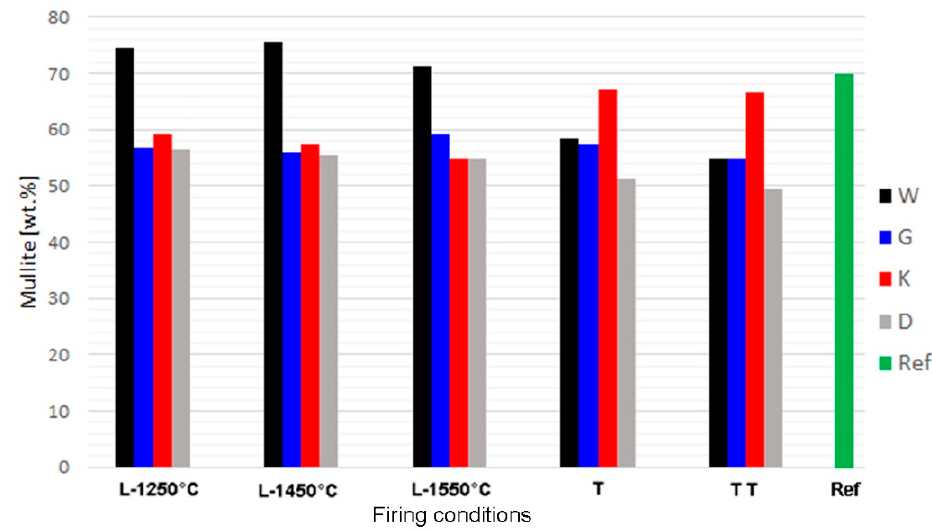
Figure 2. Contents of mullite in synthetised samples and reference material; L = l aboratory firing, T,TT = one and two cycles of firing in industrial tunnel kiln.